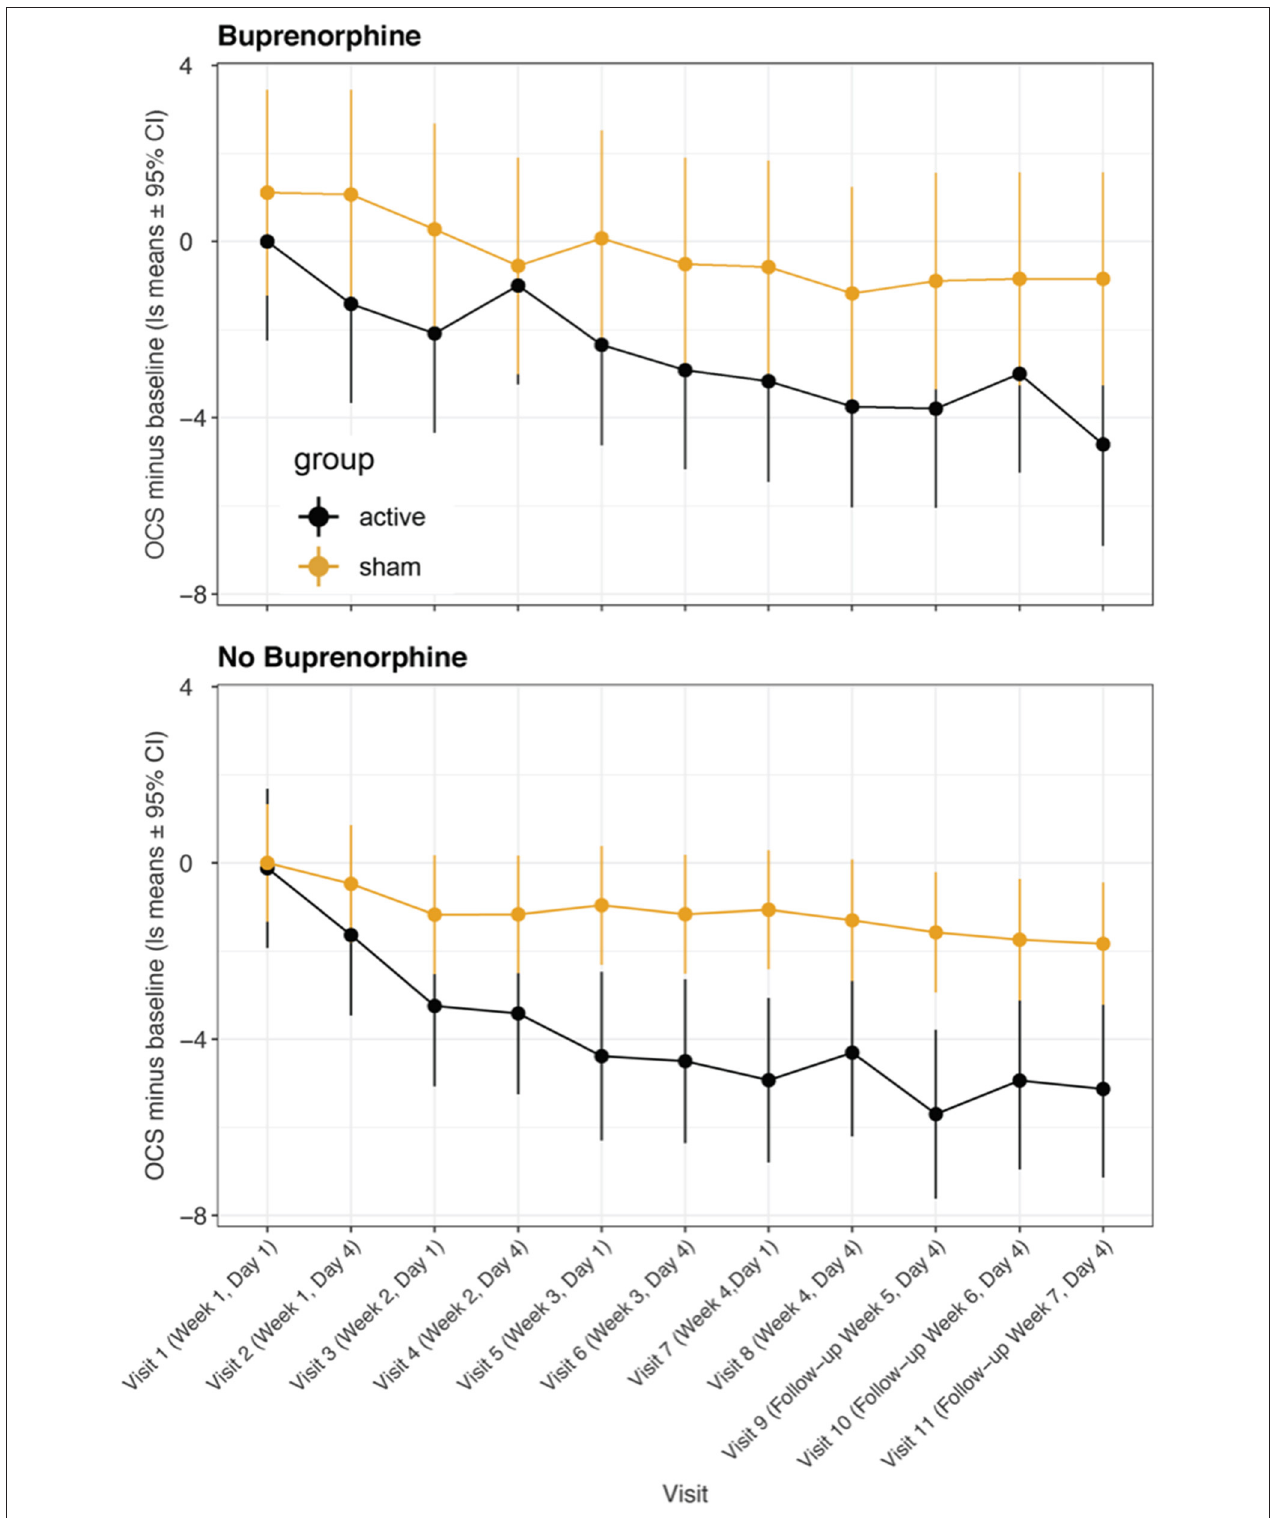
FIGURE 4 | Least square means for opioid craving scores minus baseline from mixed model comparing participants receiving buprenorphine/suboxone vs. participants not receiving medication management. Data are means ± 95% confidence intervals. A significant treatment:visit interaction was present in both groups of